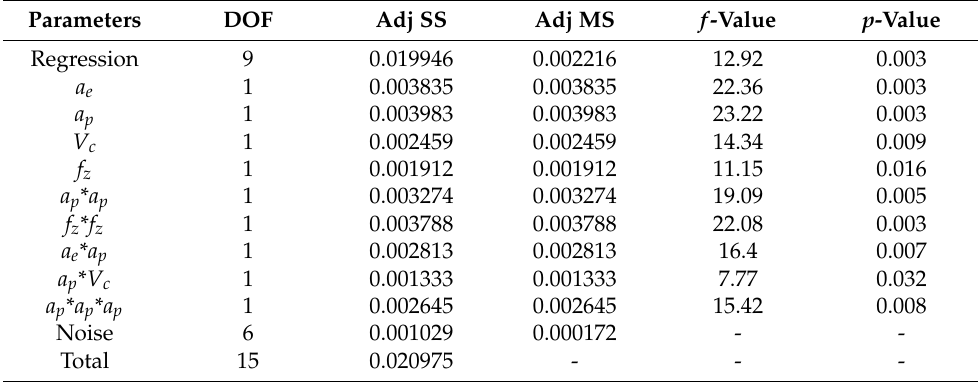
Figure 11. Experimental data [L 16 (4 4 )] and fitting results of surface roughness R a . Table 5. ANOVA for surface roughness.